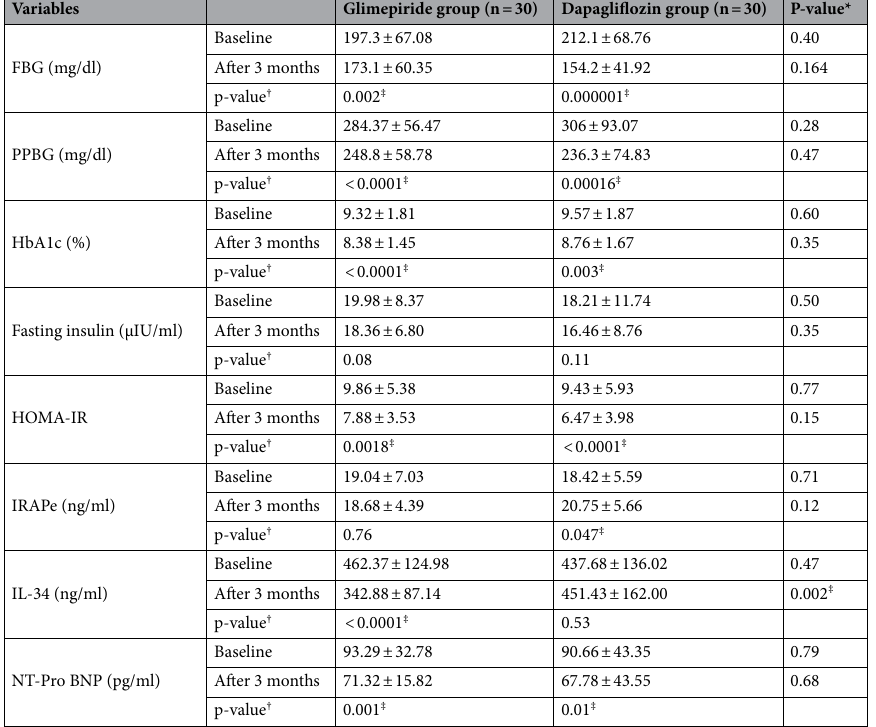
Table 2. The outcomes of the study for both groups at baseline and 3 months after intervention. Data are presented as mean ± SD. Data are analyzed using independent sample t-test or paired sample t-test as appropriate. The significance level was set at p < 0.05. FBG fasting blood glucose, PPBG postprandial blood glucose, HbA1C glycated hemoglobin, HOMA-IR Homeostatic model assessment of insulin resistance, IRAPe extracellular domain of insulin regulated aminopeptidase, IL-34 interleukin-34, NT-proBNP N -terminal pro b-type natriuretic peptide. † Paired sample t-test. *Independent sample t-test. ‡ Statistically